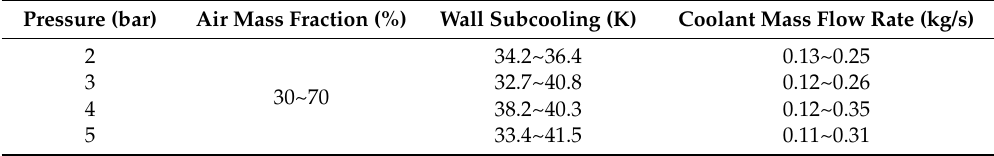
Table 1. Test matrix of the finned tube experiment.